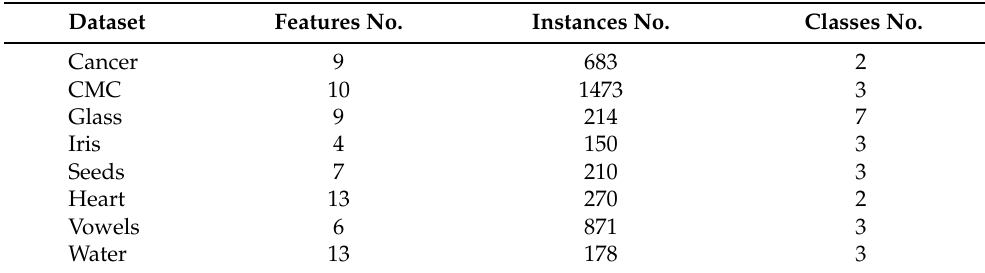
Table 12. UCI data clustering benchmark